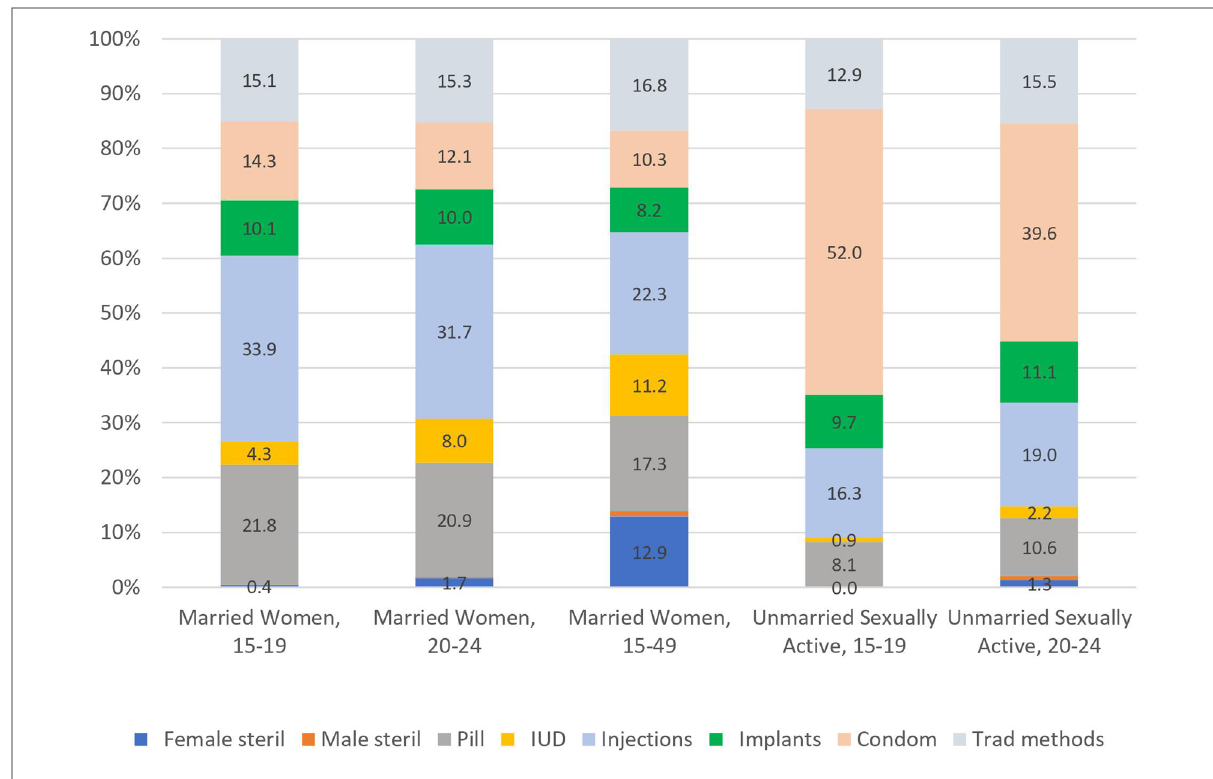
FIGURE 1 Method Mix by population subgroups, All countries, latest DHS